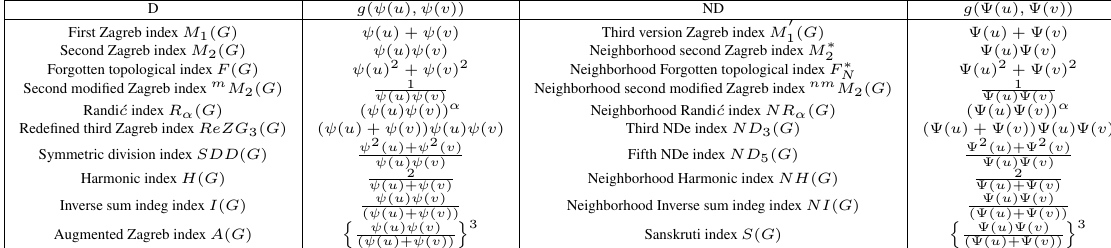
Table 1: Description of some topological